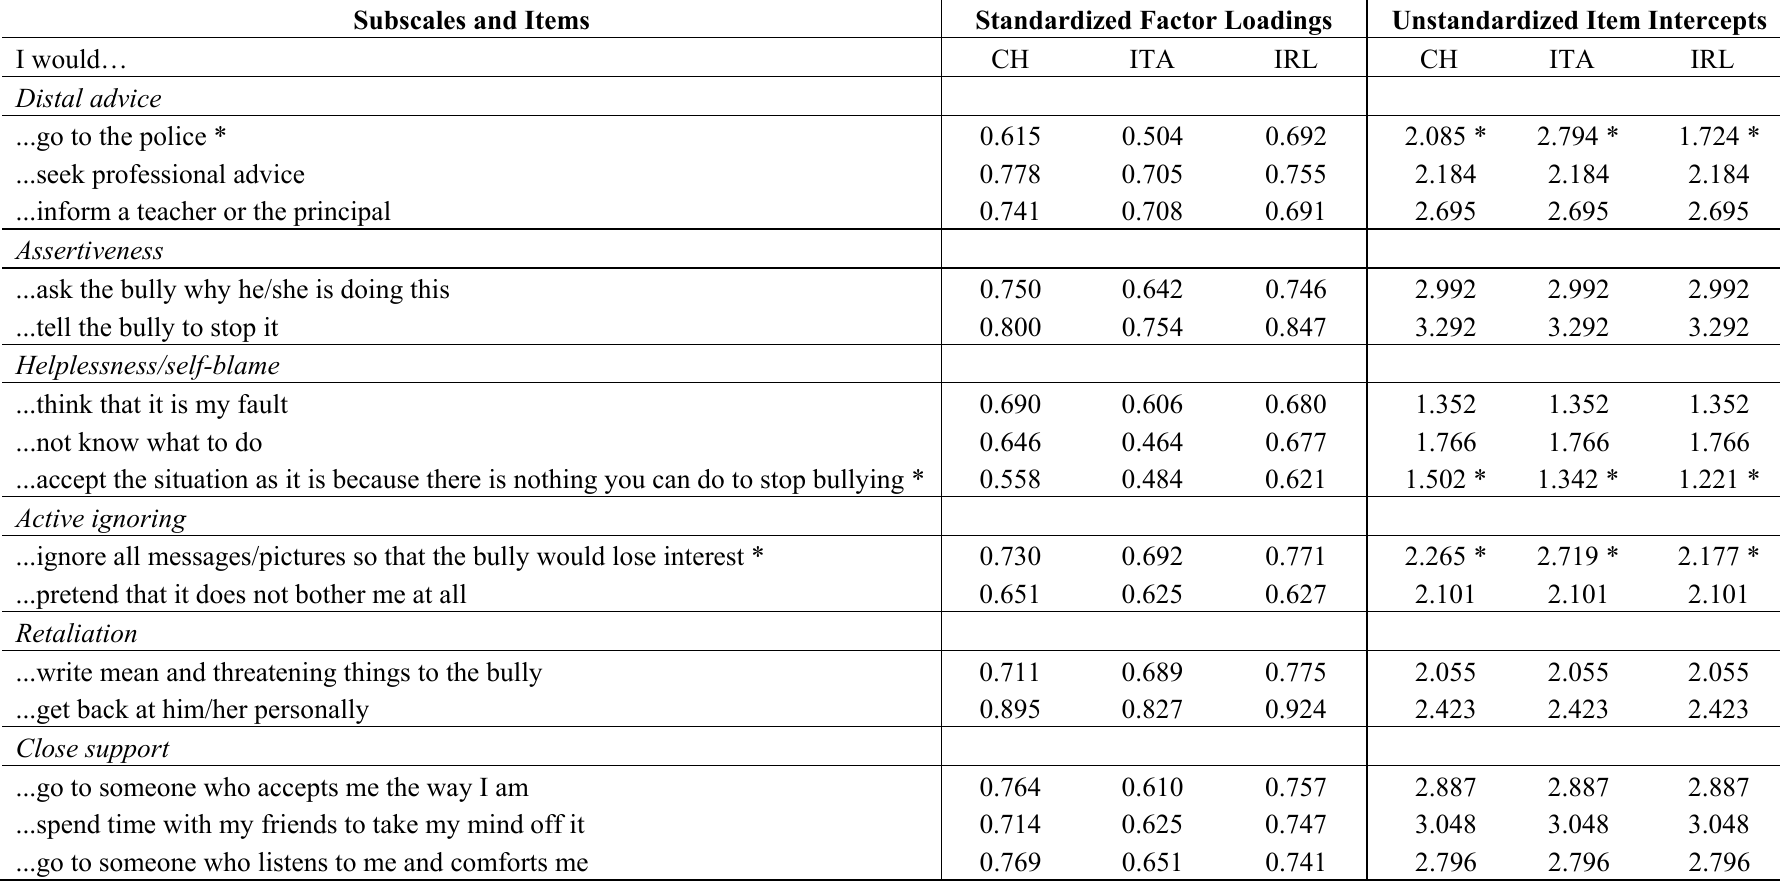
Table 2. Standardized factor loadings and unstandardized item intercepts for each country (based on the partial scalar invariance model of Stage 3, N =